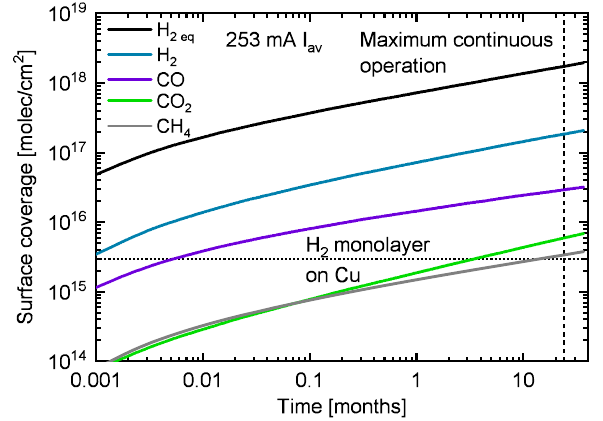
FIG. 6. Worst case of estimated surface coverages on the CB over time, for a continuous operation during Phase 1 [40].